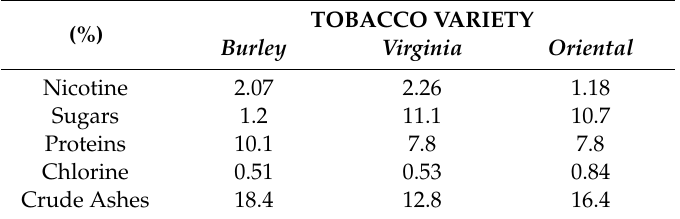
Table 1. Chemical composition of three the most important varieties of tobacco.